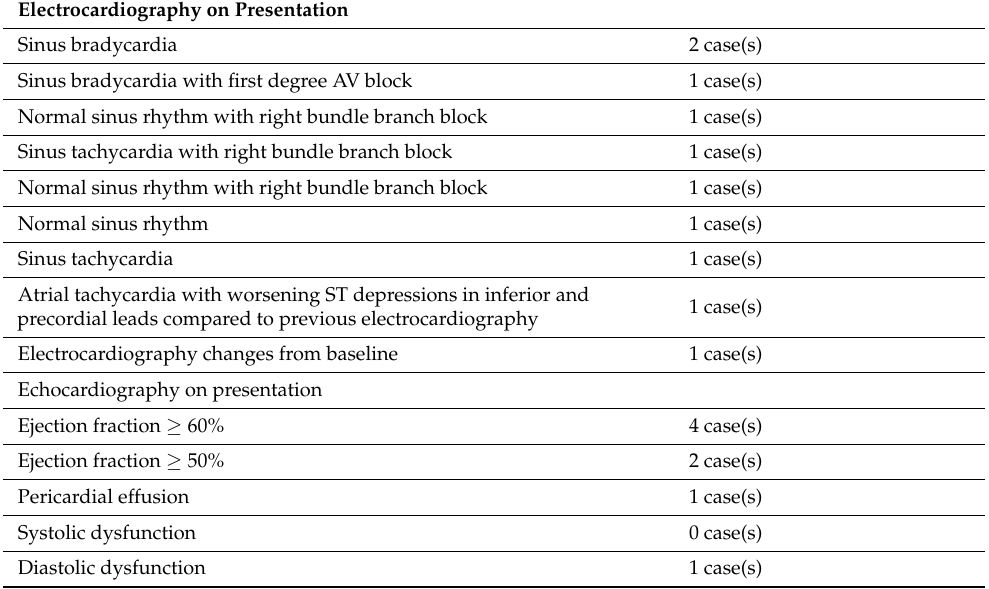
Table 3. Electrocardiography and echocardiography parameters for immune checkpoint inhibitor (ICI)-treated patients at the time of presentation with suspected